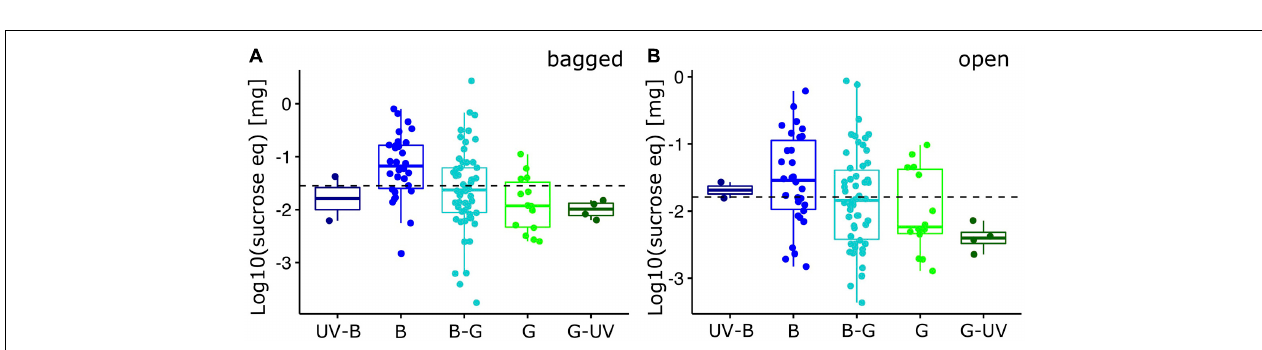
FIGURE 3 | Nectar standing crop of alpine flowering plants (individual flowers). Log10-transformed maximum reward quantity, expressed as mg sucrose equivalent per flower for bumble bee visited plant species ( N = 105). Reward quantity was measured for (A) bagged flowers and (B) open flowers. Box-plots indicate the median (line) and interquartile range (IQR, i.e., Q25-Q75; box). Lower and upper whiskers indicate Q25-1.5*IQR and Q75+1.5*IQR, respectively. The horizontal dashed line indicates the overall mean. Individual data points have been added with random X -axis jitter. X -axis categories are the five hexagon categories used in